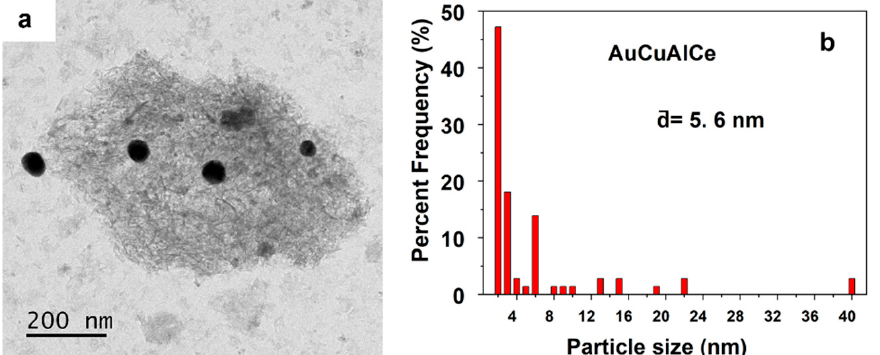
Figure 11. Particle size observed by ( a ) TEM imagen and ( b ) statistical distribution, of fresh AuCuAlCe bimetallic catalyst.